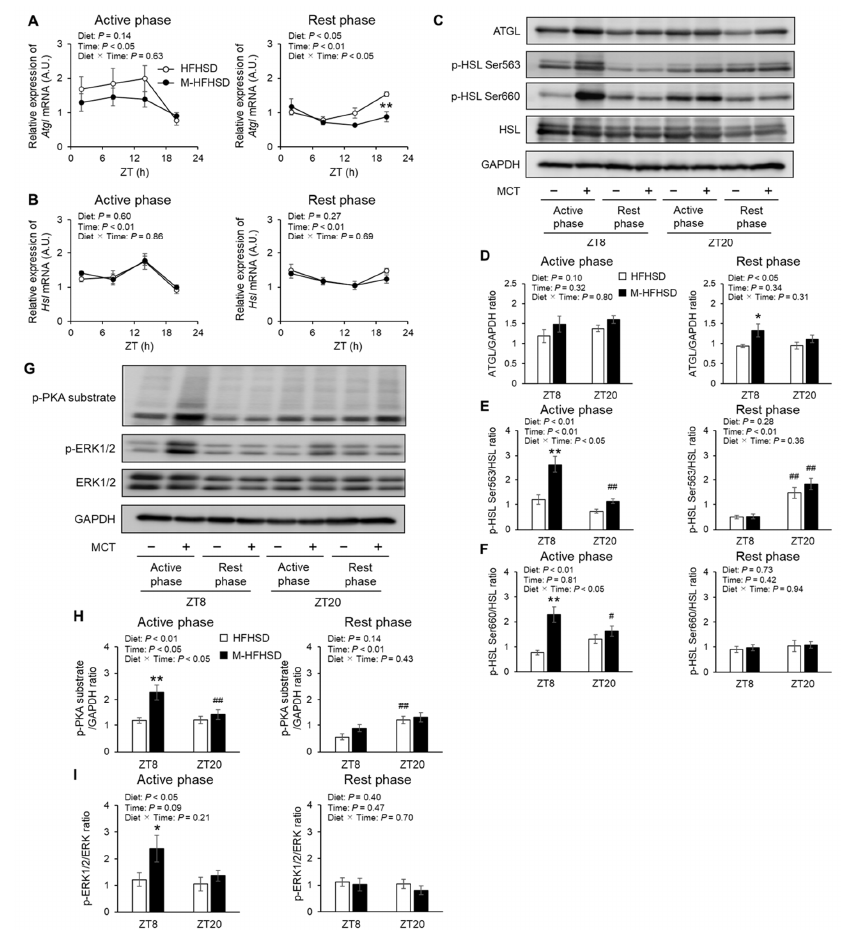
Figure 7. Expression of lipolytic genes and proteins and lipolysis-related signaling in epididymal white adipose tissue. Expression levels of Atgl ( A ) and Hsl ( B ) mRNA at indicated times in epididymal white adipose tissues of mice. ( C ) Protein expression of ATGL, phosphorylated HSL on Ser563, phosphorylated HSL on Ser660, total HSL and GAPDH in epididymal white adipose tissue extracts from mice. ( D – F ) Ratios of ATGL-to-GAPDH and phosphorylated protein-to-total protein. ( G ) Protein expression of phosphorylated PKA substrate, phosphorylated ERK, total ERK, and GAPDH in epididymal white adipose tissue extracts from mice. ( H , I ) Ratios of phosphorylated PKA substrate- to-GAPDH and phosphorylated ERK-to-total ERK. Data are mean ± SEM ( n = 4). * p < 0.05 and ** p < 0.01 vs. HFHSD at same time. # p < 0.05 and ## p < 0.01 vs. same diet at ZT8. HFHSD, high-fat high- sucrose diet; MCT, medium-chain triglyceride; M-HFHSD, high-fat high-sucrose diet containing medium-chain triglyceride; ZT, zeitgeber time.